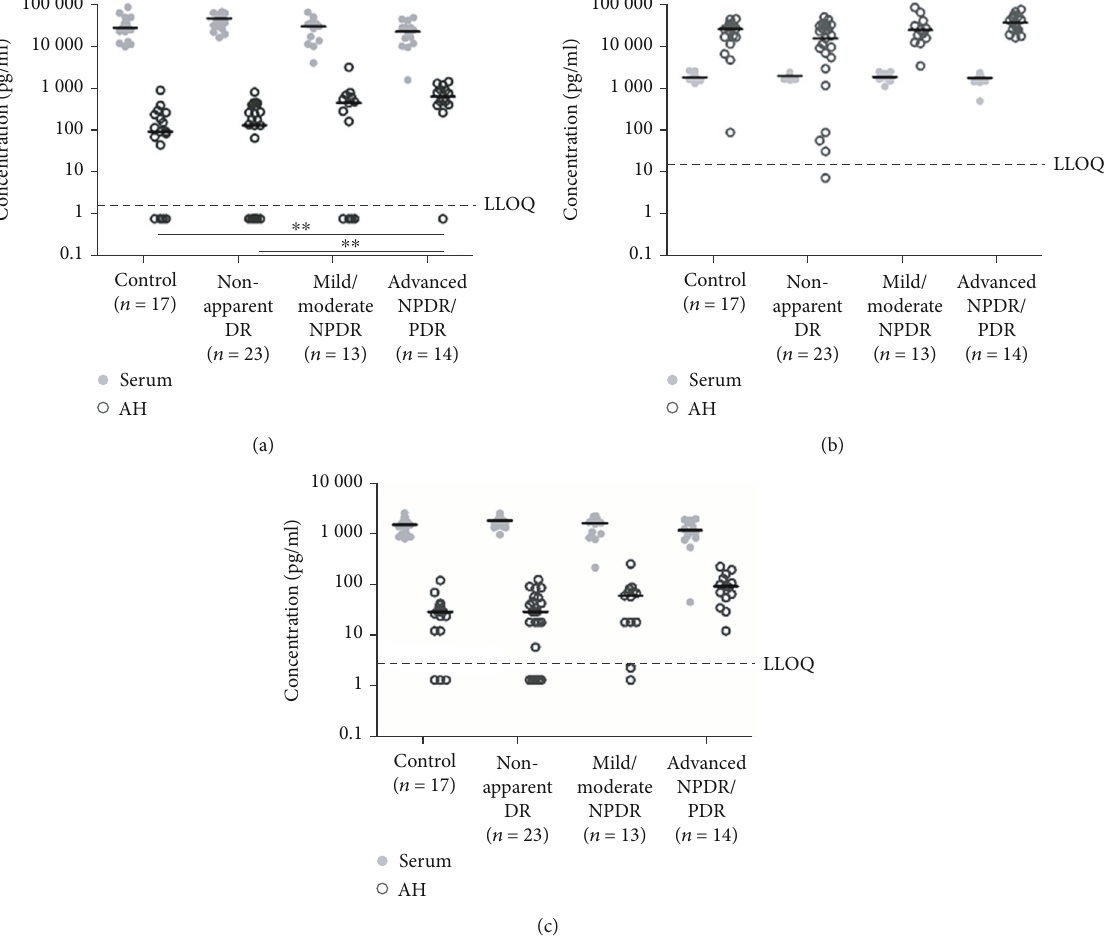
Figure 1: Scatter plots (log scale pg/ml) showing the concentrations of TGF- β 1 (a), TGF- β 2 (b), and TGF- β 3 (c) in serum and AH throughout the di ff erent stages of DR. The values below the LLOQ were replaced with half the value of the LLOQ. Black lines represent the median value for each group. The dotted line shows the LLOQ of the assay for each protein. ∗∗ p < 0 : 01